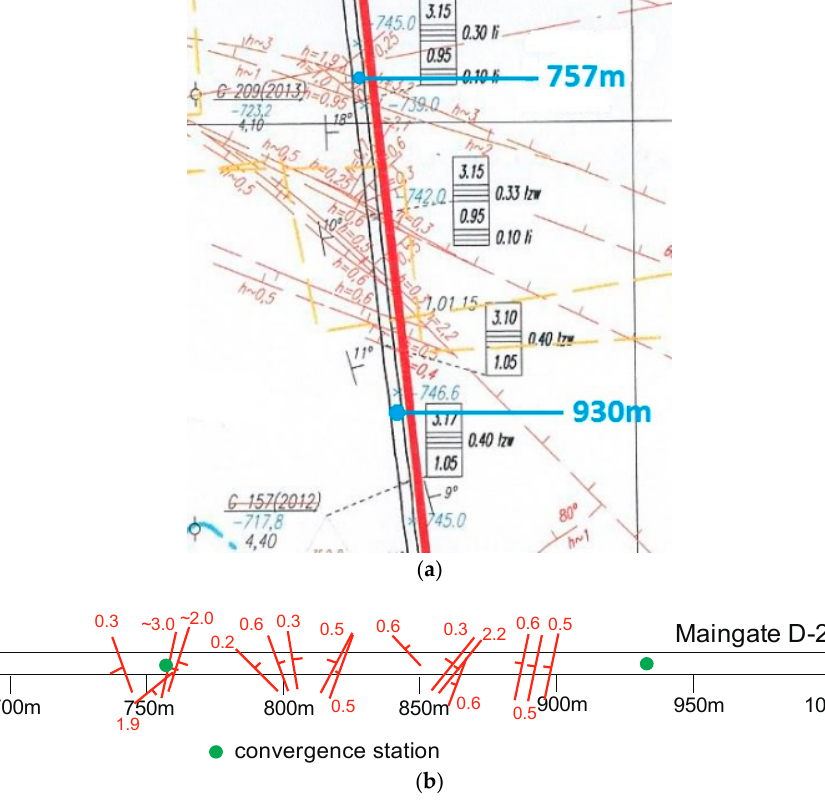
Figure 1. Faults position and the convergence stations in Maingate D-2; ( a ) The map of Maingate D-2 ( b ) The convergence stations layout.